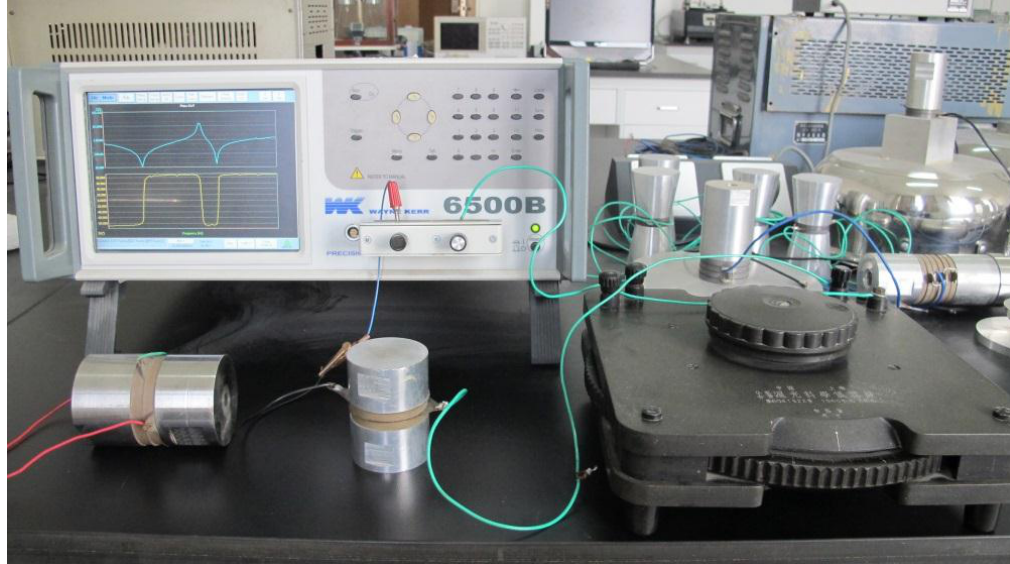
Figure 12. Experimental set-up for the measurement of the frequency response.